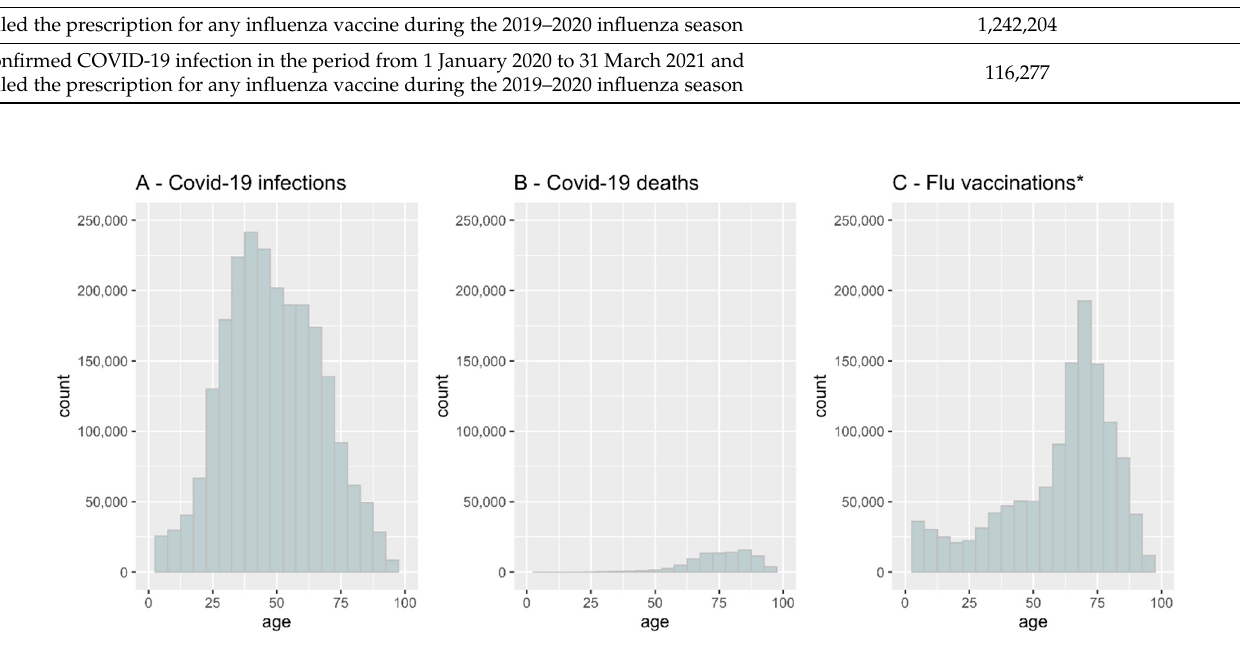
Figure 3. COVID-19 infection rate as a percentage of the population by age and sex based on demo- graphic data from December 2019. Our analysis indicated that the impact of the influenza vaccination in the two years preceding COVID-19 infection depended on the age of the individual. For people below 60 years old, after controlling for age, there was no evidence in the data of the vaccination influence (Figure 4). The same analysis showed that there was no statistically significant association between the mortality and sex ( p = 0.74). To measure the impact of the influenza vaccine on COVID-19 mortality, a generalized linear model with a binary response was applied. Such a model can be symbolically writ- ten as: y|X ~ Bernoulli( π ), with g( π ) = X β + ε . Here, y is a binary response corresponding to the death/survival status of people infected with COVID-19, and X is a matrix with columns representing covariates, i.e., age, sex, flu vaccination status and interactions be- tween these factors. Errors ε are iid, and the link function g(.), selected according to the Akaike’s Information Criterion [27], is defined as Φ − 1 (inverse Gaussian distribution). A probability of death π is estimated directly from the model, with confidence intervals (Fig- ures 4 and 5) established for the entire regression curve using the Working–Hotelling method [28]. The odds ratios and their confidence intervals were calculated using the Delta method [29]. For patients 60+ years of age, we found that the influenza vaccination is associated with a lower probability of death caused by the SARS-CoV-2 virus compared to unvac- cinated, and this difference, although small, remained significant (Figure 5). The magni- tude of the difference increased with age.